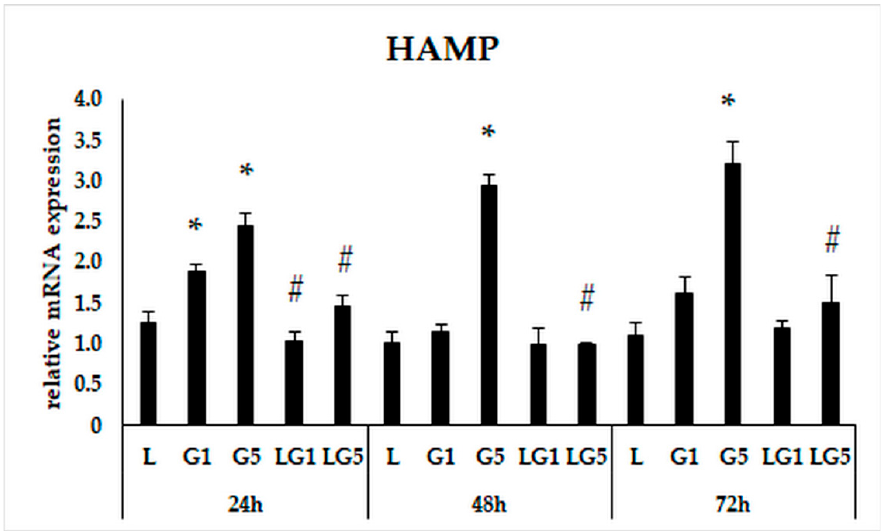
Figure 5. Determination of mRNA expression of HAMP after lutein and Glu treatments of the SH-SY5Y cells. SH-SY5Y cells were treated with 10 ng/µL of lutein, 1 mM, 5 mM Glu, or lutein with Glu together to detect the changes in the expression of HAMP. The gene expression measurements were performed by SYBR Green RT-PCR protocol using β -actin as a housekeeping gene. The relative expression of controls was regarded as 1. The bars represent the mean values (±standard deviation error bars, SD) of three independent experiments ( n = 3) performed in triplicate and are presented relative to their control cells. The * marks the statistical significance of Glu treatments compared to control, # signs the statistical significance of combined (lutein with Glu) treatments compared to the Glu treatments at 24 h, 48 h, and 72 h ( p < 0.05).